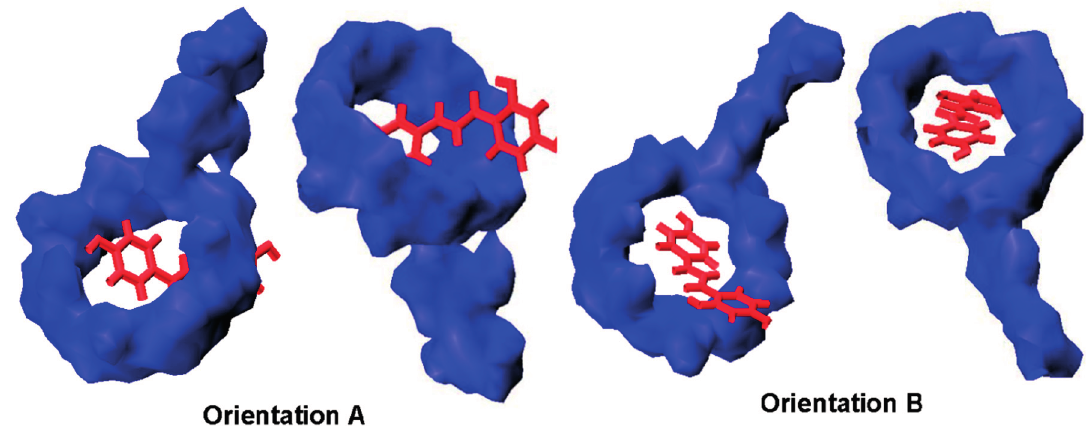
Figure 8. Complexation snaps of the ILTG/G 2 - β -CD complex in the gas phase by ONIOM (B3LYP/6-31+G(d):PM3) calculations. The left two snaps denote the conformations obtained from Orientation A, while the right two snaps denote the conformations obtained from Orientation